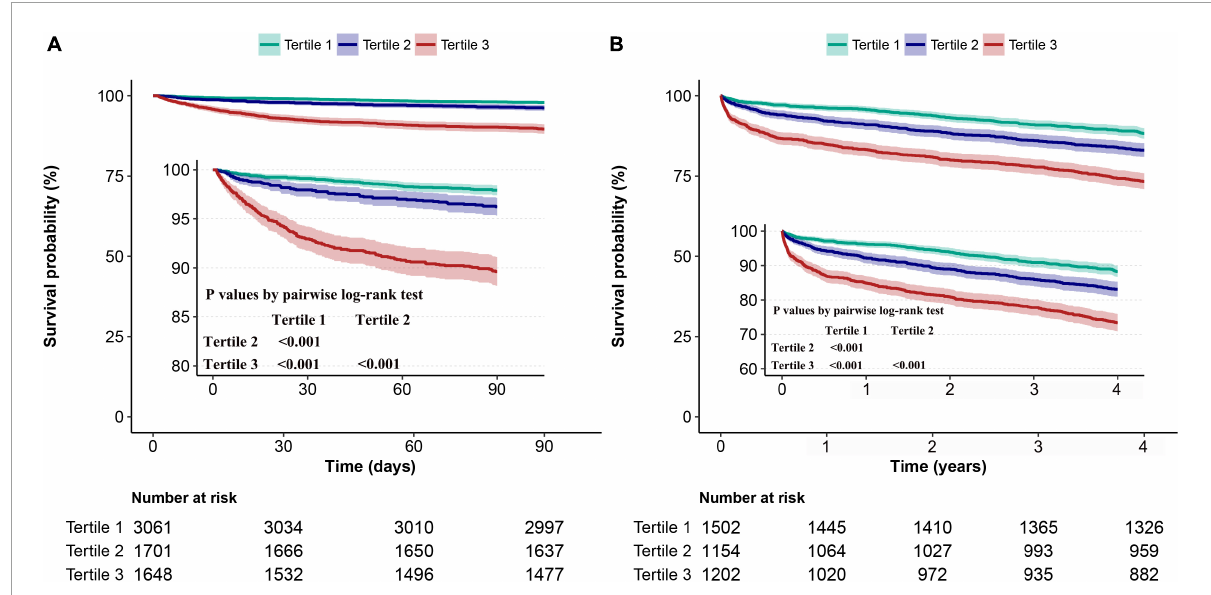
FIGURE3 Kaplan-Meier survival analysis among patients stratified by the tertile of the initial AG. The comparisons of (A) 90-day and (B) 4-year survival of the three tertiles were made by the pairwise log-rank test.